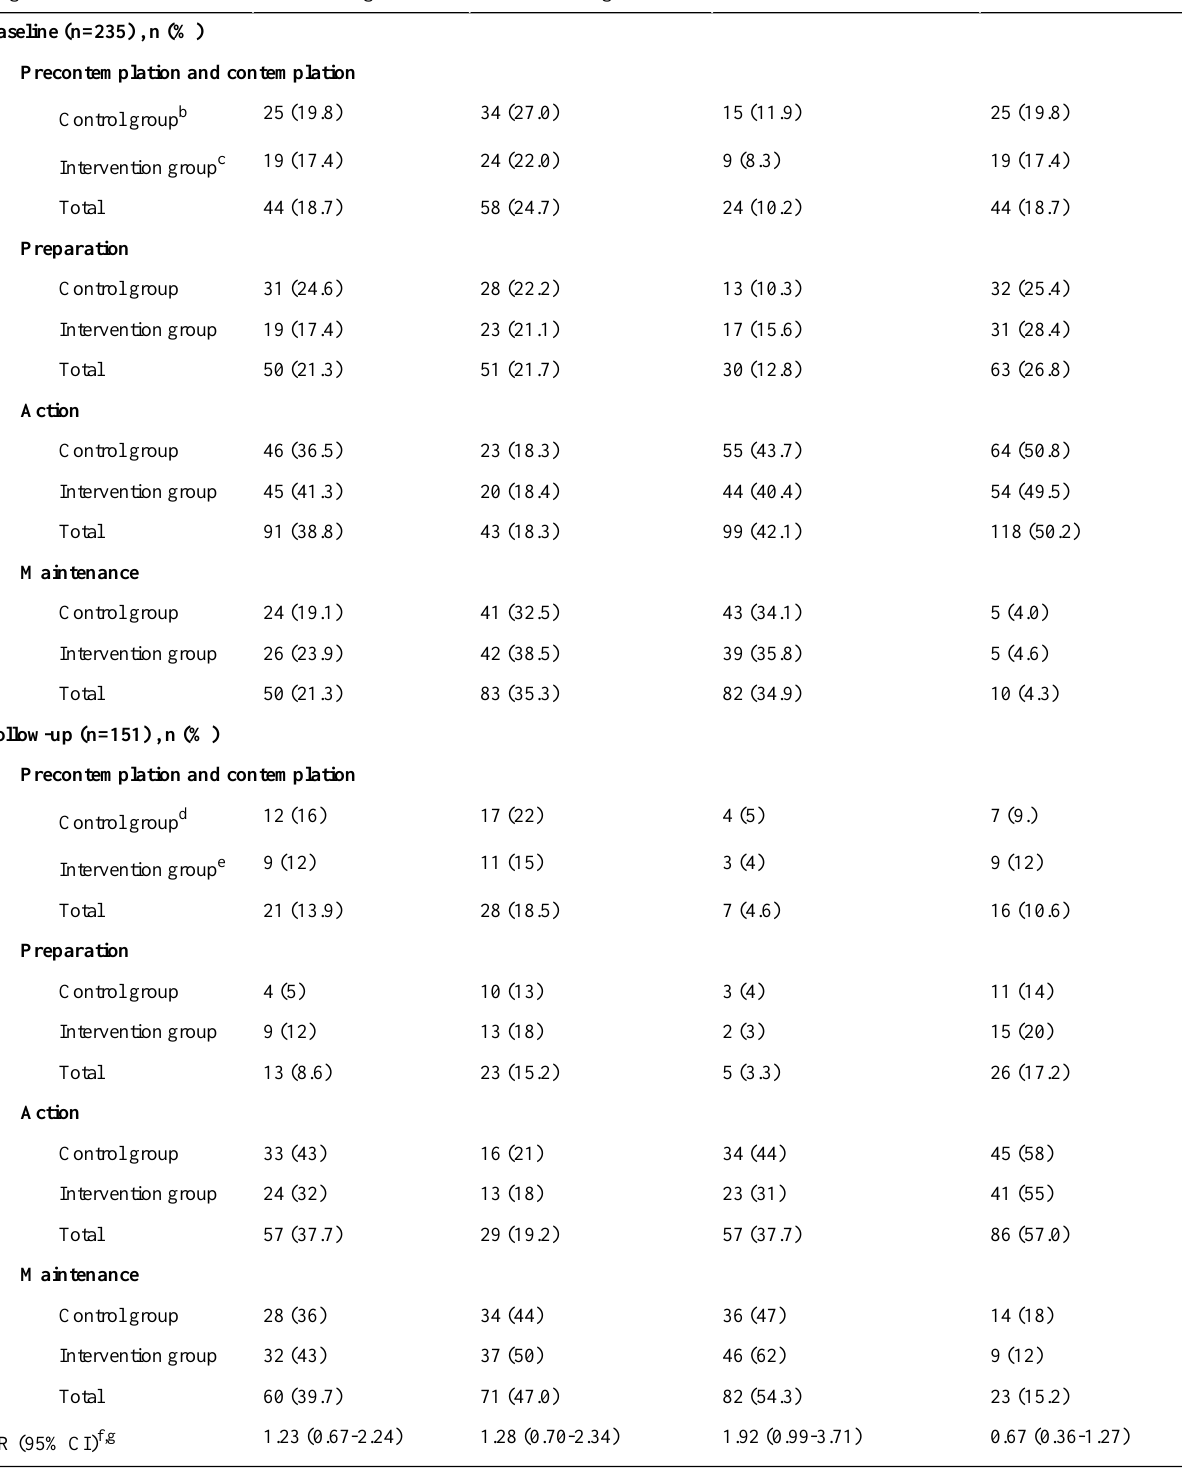
Table 3. Proportion of individuals in each stage of readiness for risk reduction behaviors at baseline and follow-up and odds ratios comparing the mean values of readiness to change between intervention and control groups at